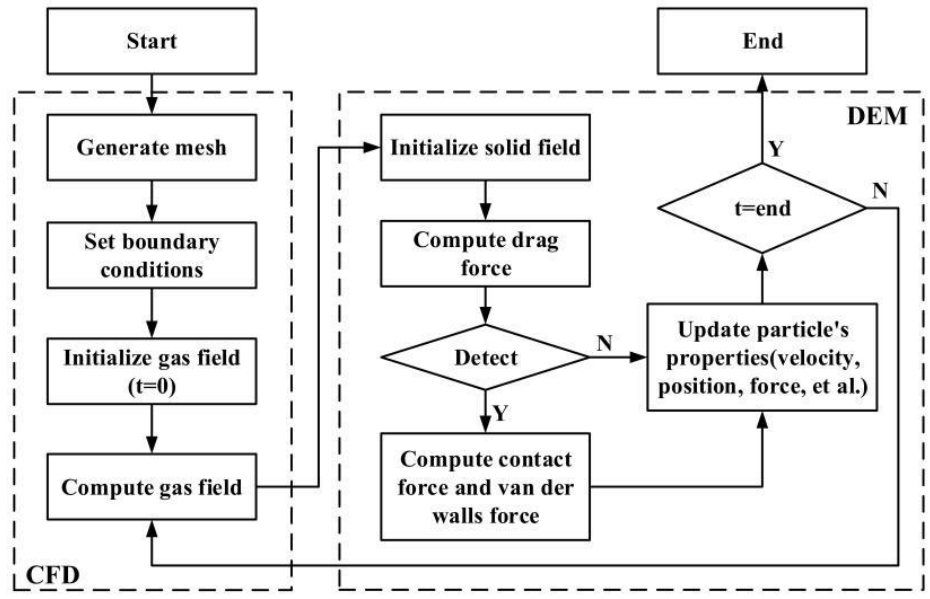
Figure 1. Flowchart of the CFD-DEM coupling.